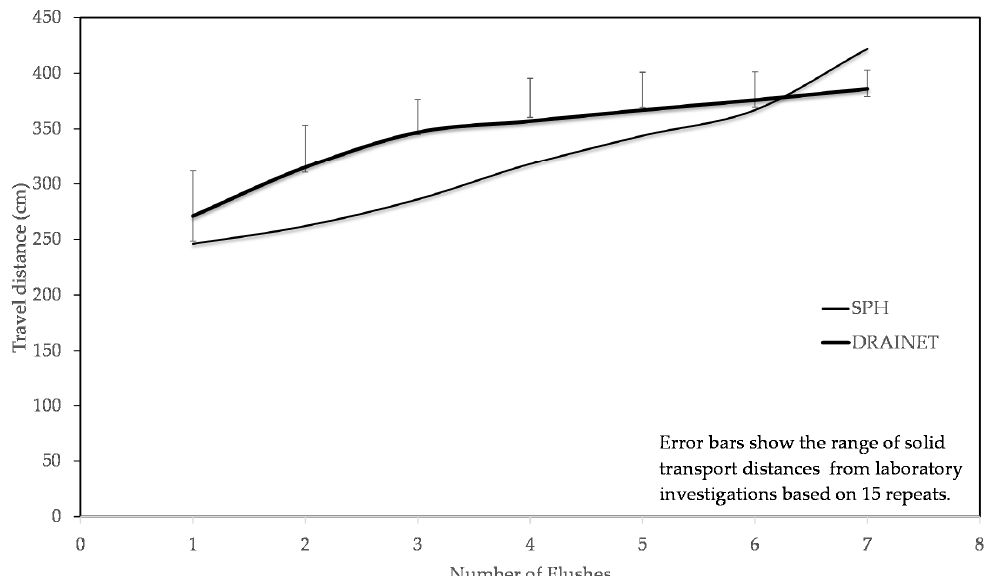
Figure 6. Comparison between laboratory results, DRAINET results, and SPH results for a simulated solid of 80 mm length with a diameter of 36 mm, a specific gravity (SG) of 1.1, a mass of 85 g, and a density of 1100 kgm − 3.